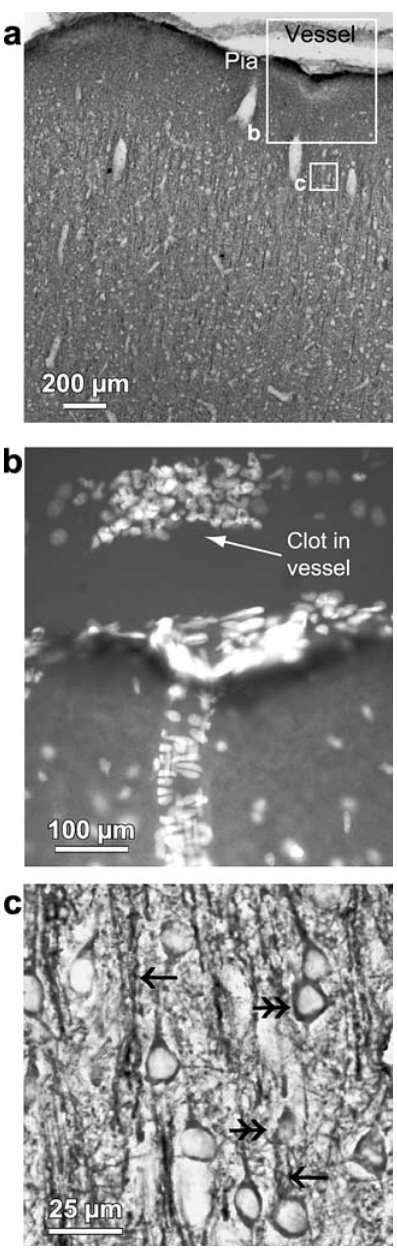
Figure 4. Neuronal Integrity near Photothrombotic